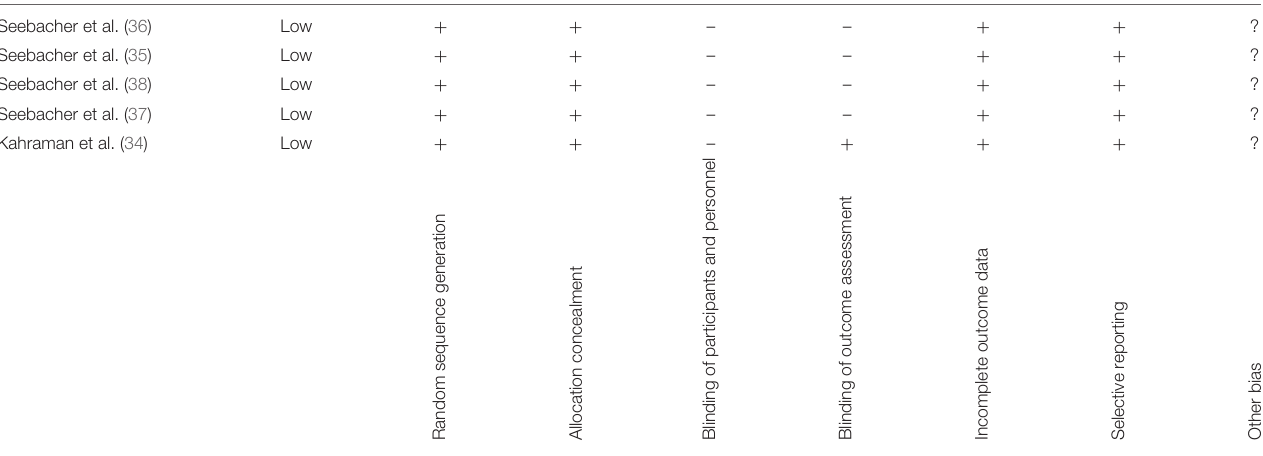
TABLE 3 | Risk of bias